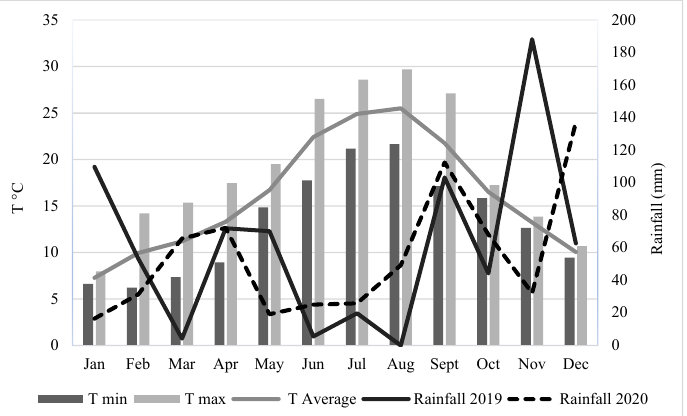
Figure 1. Yearly rainfall per month and mean values of monthly air temperature at the research area over the years 2019–2020. Data source: ISPRA (http://www.scia.isprambiente.it (accessed on 30 June 2022).